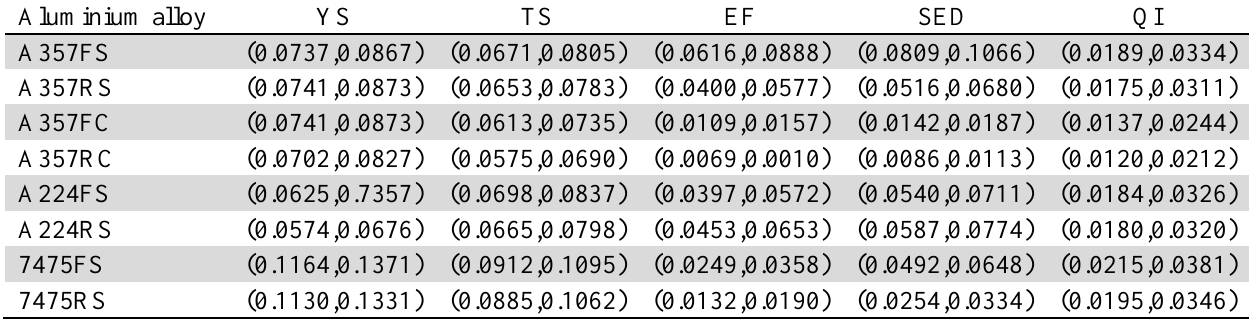
Weighted normalized grey decision matrix for aluminium alloys Aluminium alloy